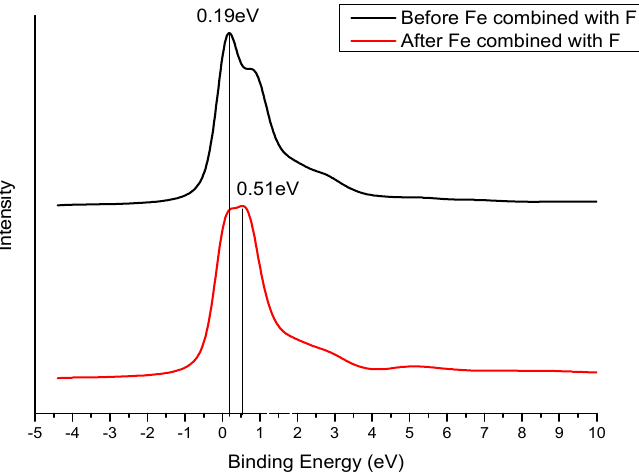
Figure 13. EELS spectrum of Nb 3d orbital in FeNb 2 O 6 (110) system before and after adding HF. The calculation confirmed the overall trend of CLS: before and after the combination of F and Nb atoms, the main peaks of the EELS spectrum under the two states shifted. Oxidation increased the binding energy of inner electrons. The greater the number of electrons lost during oxidation, the greater the increase; the reduction reduced the binding energy of inner electrons, the more electrons gained during reduction, the greater the decrease in binding energy; for an atom with a valence state electron shell structure, the shift of the binding energy of all inner electrons is almost the same. Before combining with F, the peak core energy level of Nb 3d orbital was 27.39 eV. After combining with F atoms, the main peak shifts to 27.77 eV, which increased 0.38 eV, and the shift was close to the XPS difference between Nb–O bonds and Nb–F bonds in the Nb 3d orbital, indicating that electrons were transferred from Nb atoms. Before combining with F, the peak of core-level energy the Fe 2p orbital was 0.19 eV. After combining with F, the core-level energy shifted to 0.51 eV, with an increase of 0.32 eV, indicating that electrons were transferred from Fe atoms. The binding energy of electrons inside the atoms was related to the electronegativ- ity of the bonding ions. The greater the electronegativity, the stronger the ionic property of the bonds, and therefore the greater the electron binding energy. If these compounds were replaced by ions with different electronegativity, the electron binding energy would change. Compared with the EELS of Nb 3d orbital, the change of electron binding energy on Fe 2p orbital was not as obvious as that on Nb 3d orbital. Therefore, the result of XPS analysis was very consistent with the result of DFT calculation. 4.4. Interfacial Reaction during Columbite–(Fe) Mineral Leaching The following reactions occurred during the HF acid leaching of FeNb 2 O 6 [8]: FeNb 2 O 6 + 12HF = 2H 2 NbOF 5 + FeF 2 + 4H 2 O